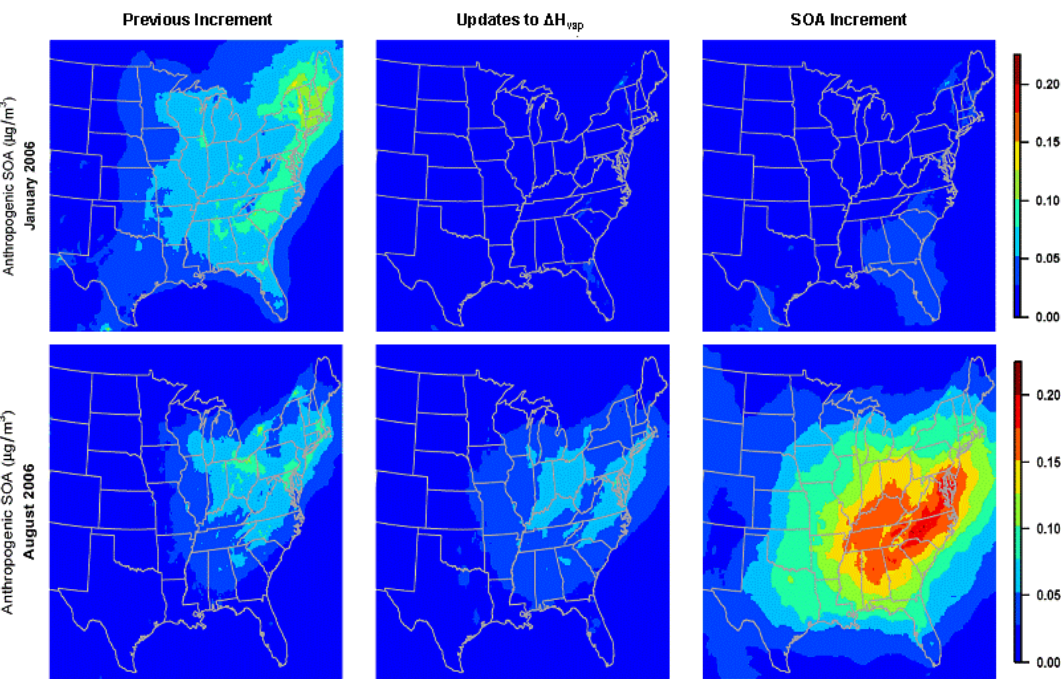
Fig. 2. Monthly average anthropogenic SOA (µg/m 3 ) for January (top row) and August (bottom row) 2006. The middle column shows the effect of reducing the enthalpies of vaporization ( 1 H vap ) compared to the previous increment (left column). The right column shows results from the final SOA module in CMAQ v4.7 described in Sect. 2.2.